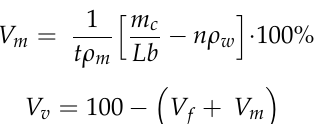
Figure 1. ( a ) Carbon fiber ( b ) E-glass fiber ( c ) Basalt fiber reinforced geopolymer composite before